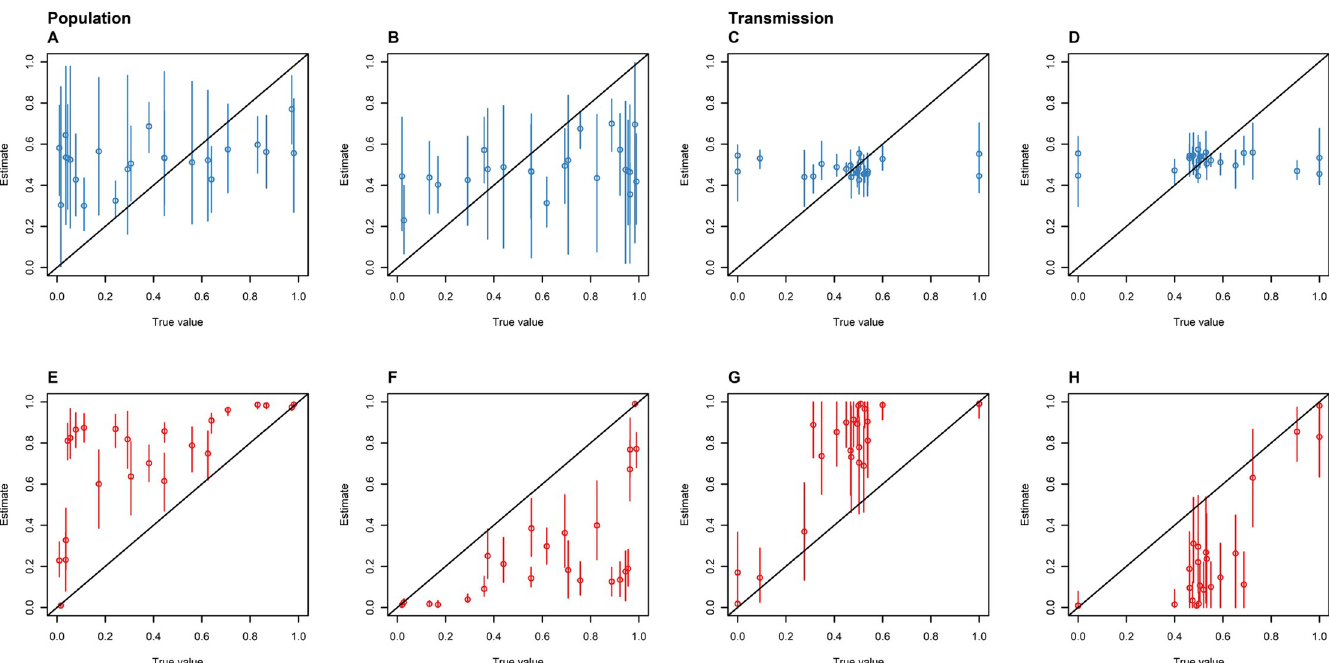
Fig 10. The proportion of time spent in the animal (A and E) and human (B and F) host populations, and the proportion of inter-population transmissions made up of animal-to-human (C and G) and human-to-animal (D and H) transmissions as estimated by the SC (blue: A-D) and DTA (red: E-F) models versus the true parameters for 23 simulated outbreaks that 100 isolates were sampled equally over time from. The diagonal line represents accurate estimates of the sampled outbreaks, the dots represent the mean, and the error bars represent the 95% HPD interval.